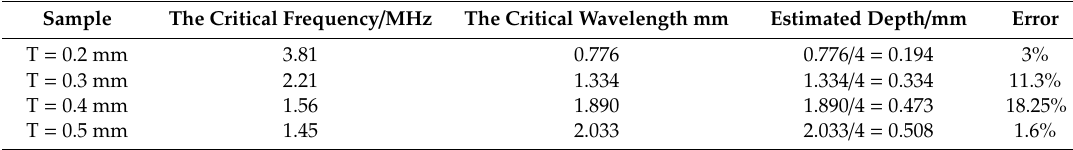
Table 3. Estimated crack depth and relative error for simulation element with the maximum size 0.2 mm.